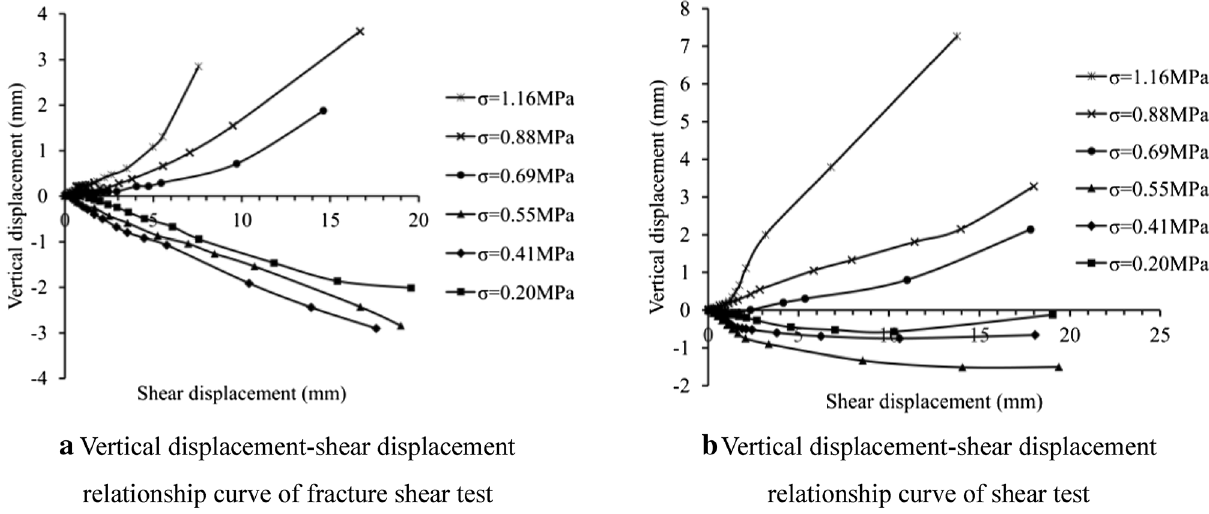
Figure 12. Vertical displacement characteristics of the sample.